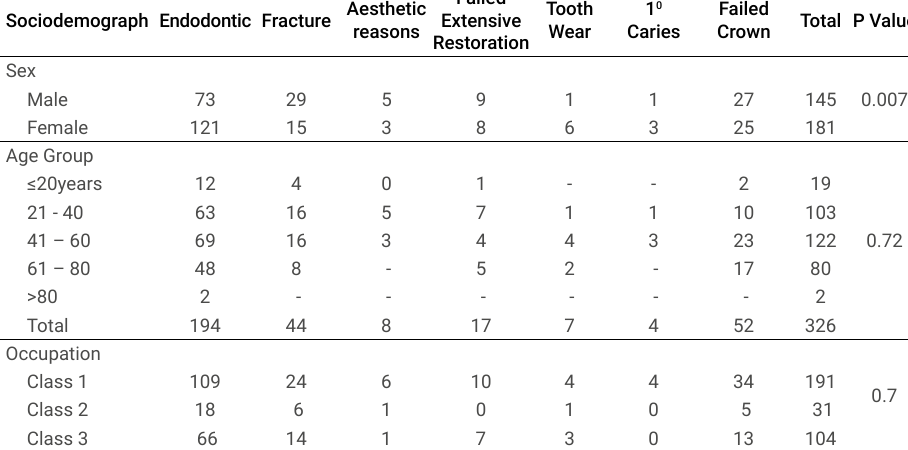
Table 3. Reason for crown placement and replacement according to sociodemographs Sociodemograph Endodontic Fracture